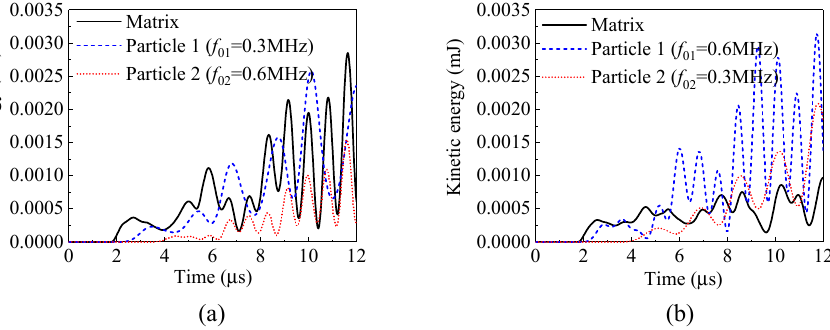
Figure 15. Kinetic energy (mJ): ( a ) f 01 = 0.3 MHz, f 02 = 0.6 MHz; ( b ) f 01 = 0.6 MHz, f 02 = 0.3 MHz.